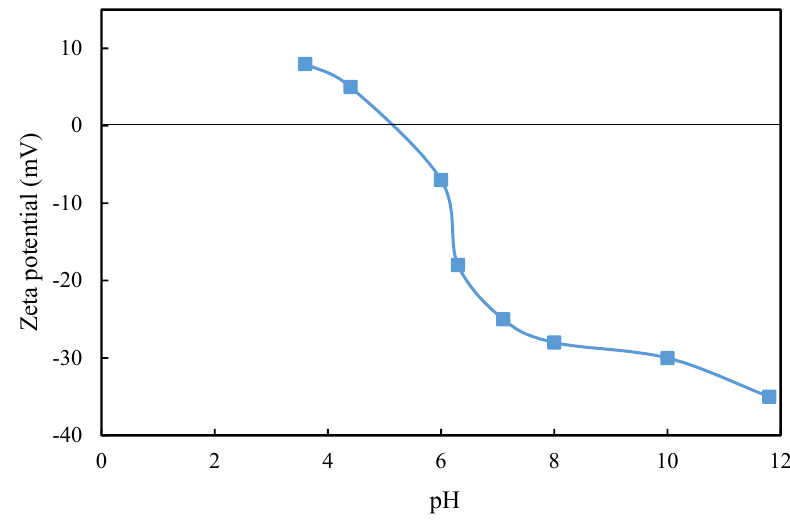
Figure 10. Zeta potential of kaolinite as a function of pH (after [13]).